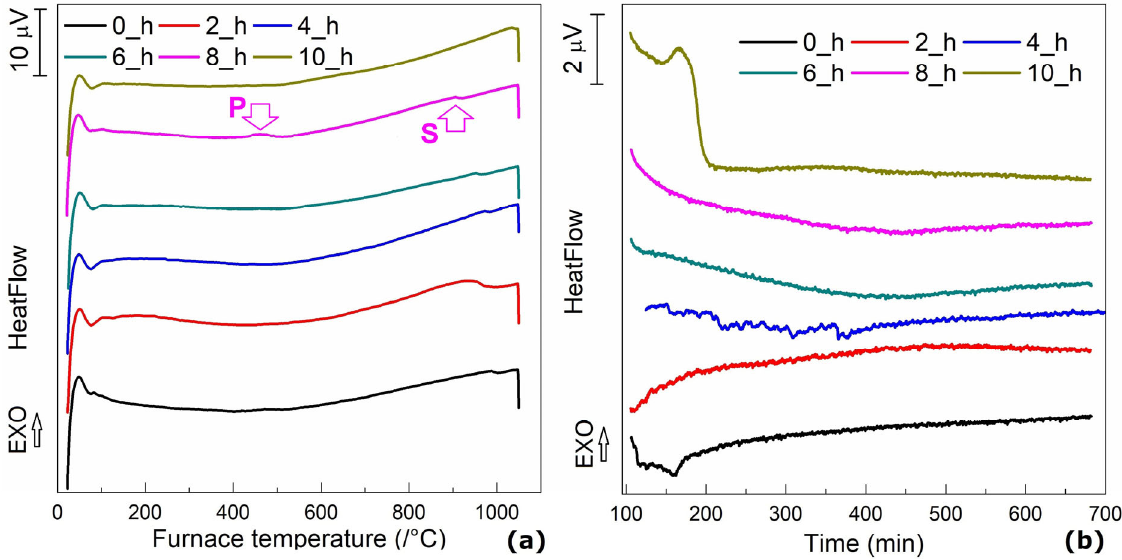
Figure 1. DSC thermograms emphasizing heat flow variations during the first two steps of solution treatment: ( a ) heating up to 1050 °C and ( b ) 10 h of holding at 1050 °C. P: precipitation; S: solvus.